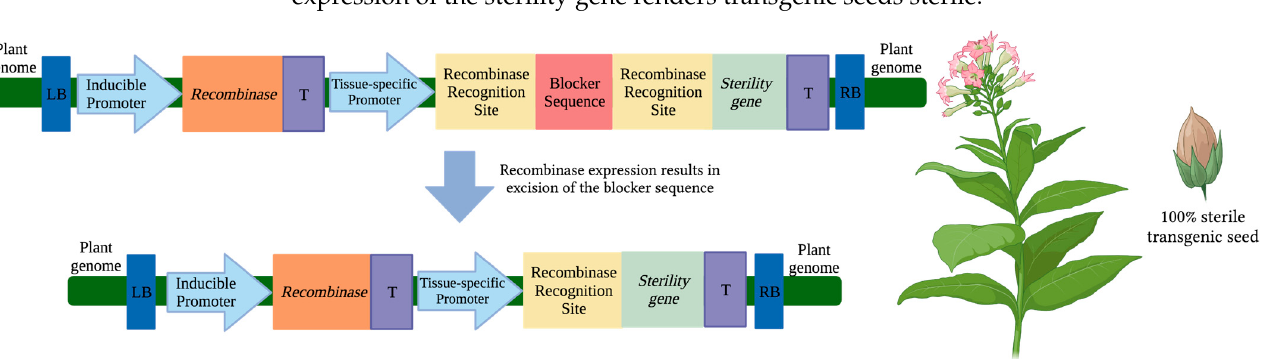
Figure 2. Conditional sterility via inducible system activation of sterility genes. Within the left (LB) and right borders (RB) of the T-DNA located in the plant genome, an inducible promoter is located upstream of a recombinase gene and terminator (T). An external stimulus is applied to induce recombinase gene expression. The recombinase enzyme subsequently excises the blocker sequence by cutting DNA segments at flanking recognition sites. The tissue-specific promoter (ex. seed-specific) is moved into close proximity of the sterility gene and transcription can occur. The sterility gene product leads to cell death. In this theoretical example, a homozygous tobacco line with a seed-specific promoter driving sterility gene expression leads to 100% sterile transgenic seeds. Figure created with Biorender.com, accessed on 18 January 2023.